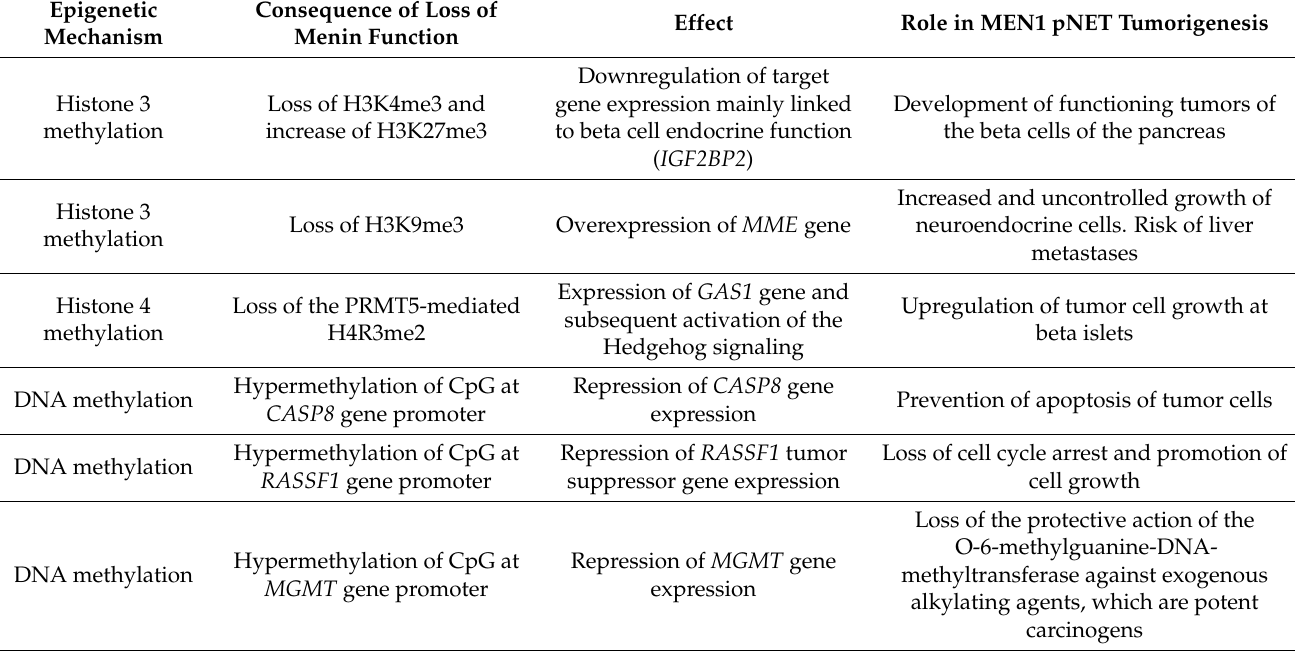
Table 1. Epigenetic mechanisms involved in MEN1-related pNET